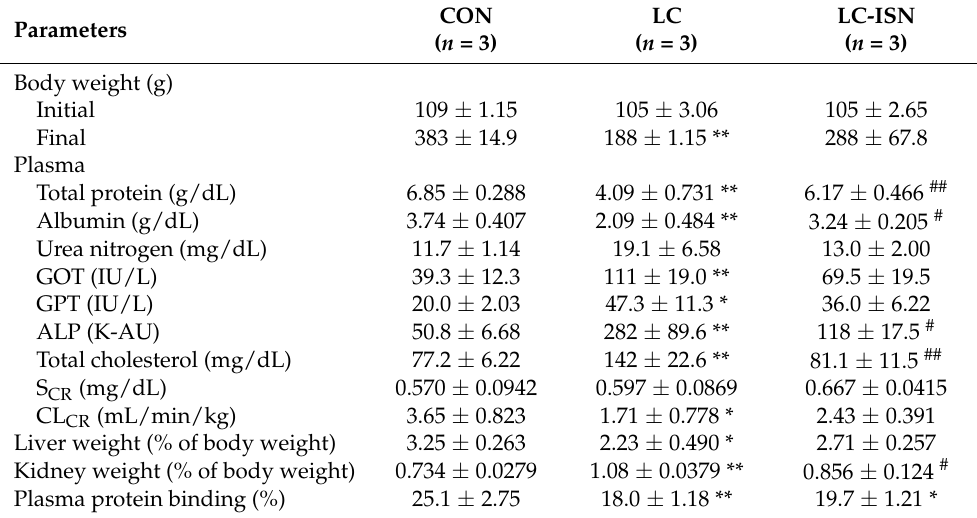
Table 1. The mean values ( ± standard deviation) of initial and final body weights, plasma concen- trations of total protein, albumin, urea nitrogen, GOT, GPT, ALP, total cholesterol, S CR , CL CR , and relative liver and kidney weights in CON, LC and LC-ISN